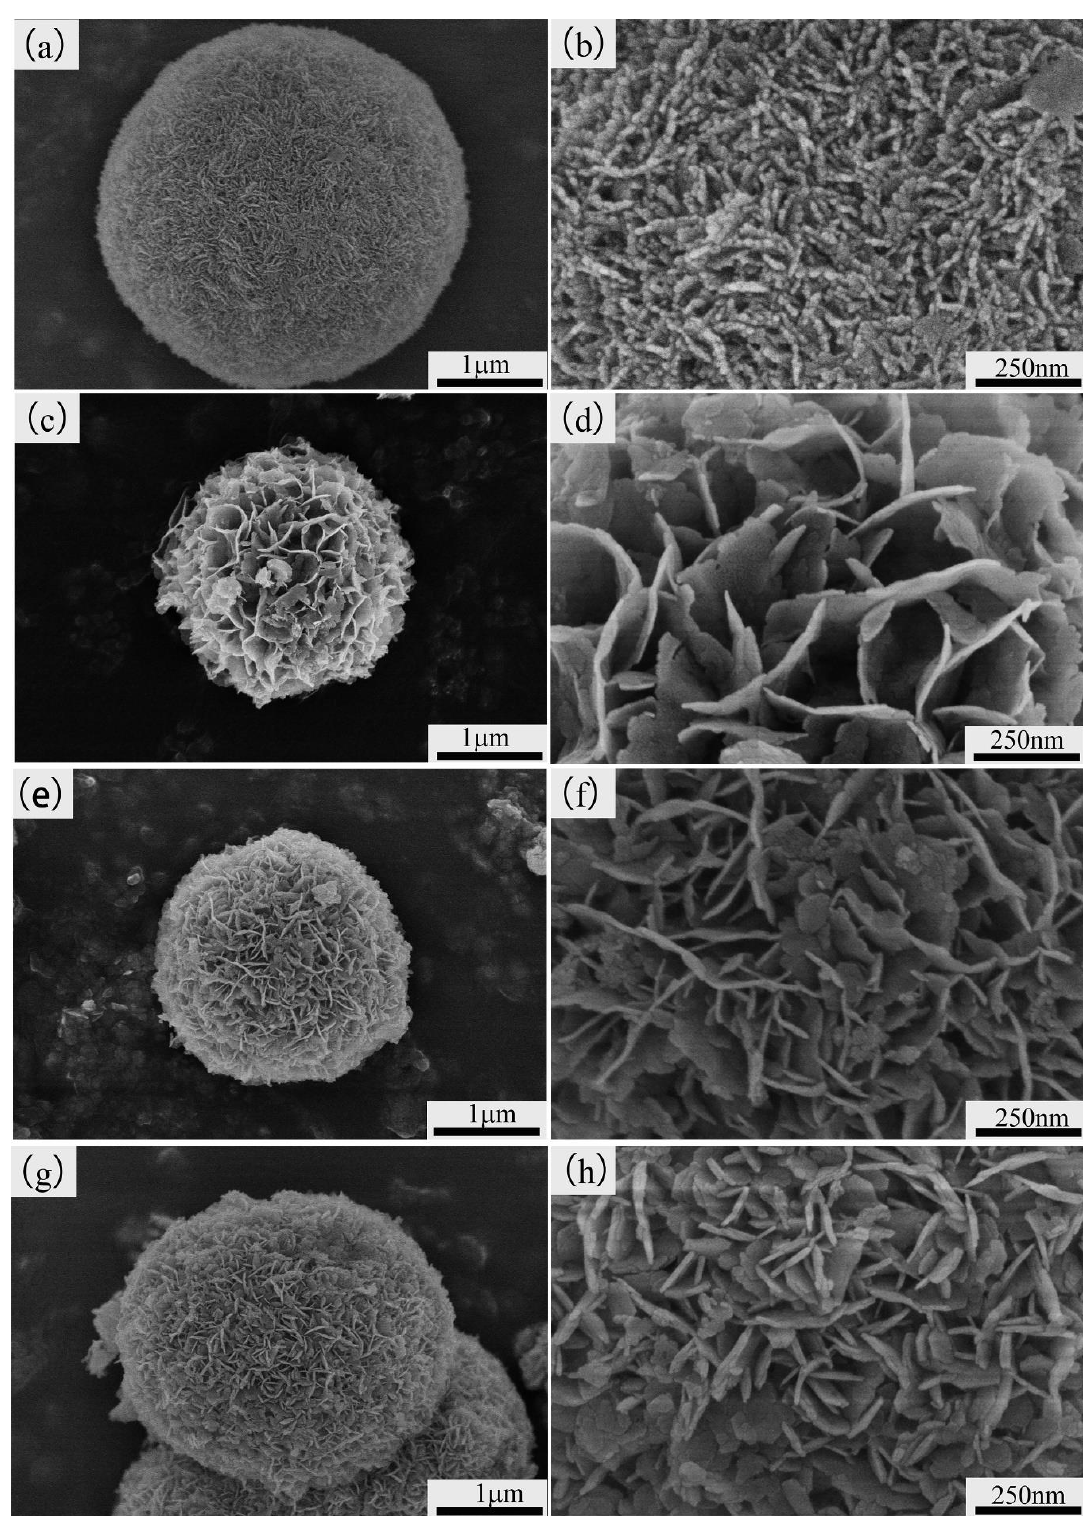
Figure 4. Field-emission scanning electron microscope (FE-SEM) images of Ni-MOF and Ni(OH) 2 samples. ( a , b ) Ni-MOF, ( c , d ) 2 M-Ni(OH) 2 , ( e , f ) 6 M-Ni(OH) 2 , and ( g , h ) 8 M-Ni(OH) 2 , respectively.